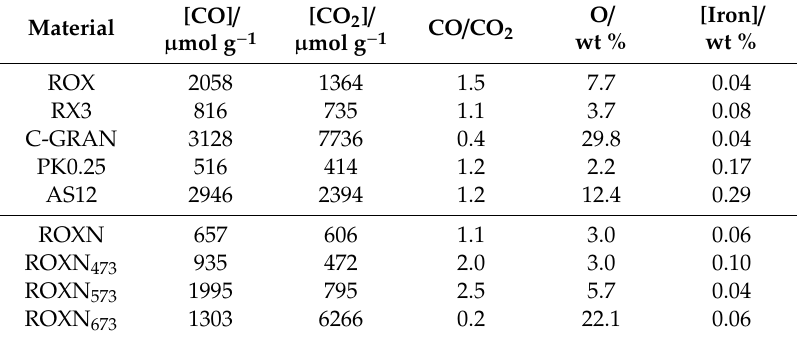
Table 2. Amounts of CO and CO 2 released by TPD, CO / CO 2 ratio, percentage of oxygen obtained from the analysis of the temperature-programmed desorption (TPD) spectra (assuming that all the surface oxygen is released as CO and CO 2 ) and iron content of the activated carbon (AC)